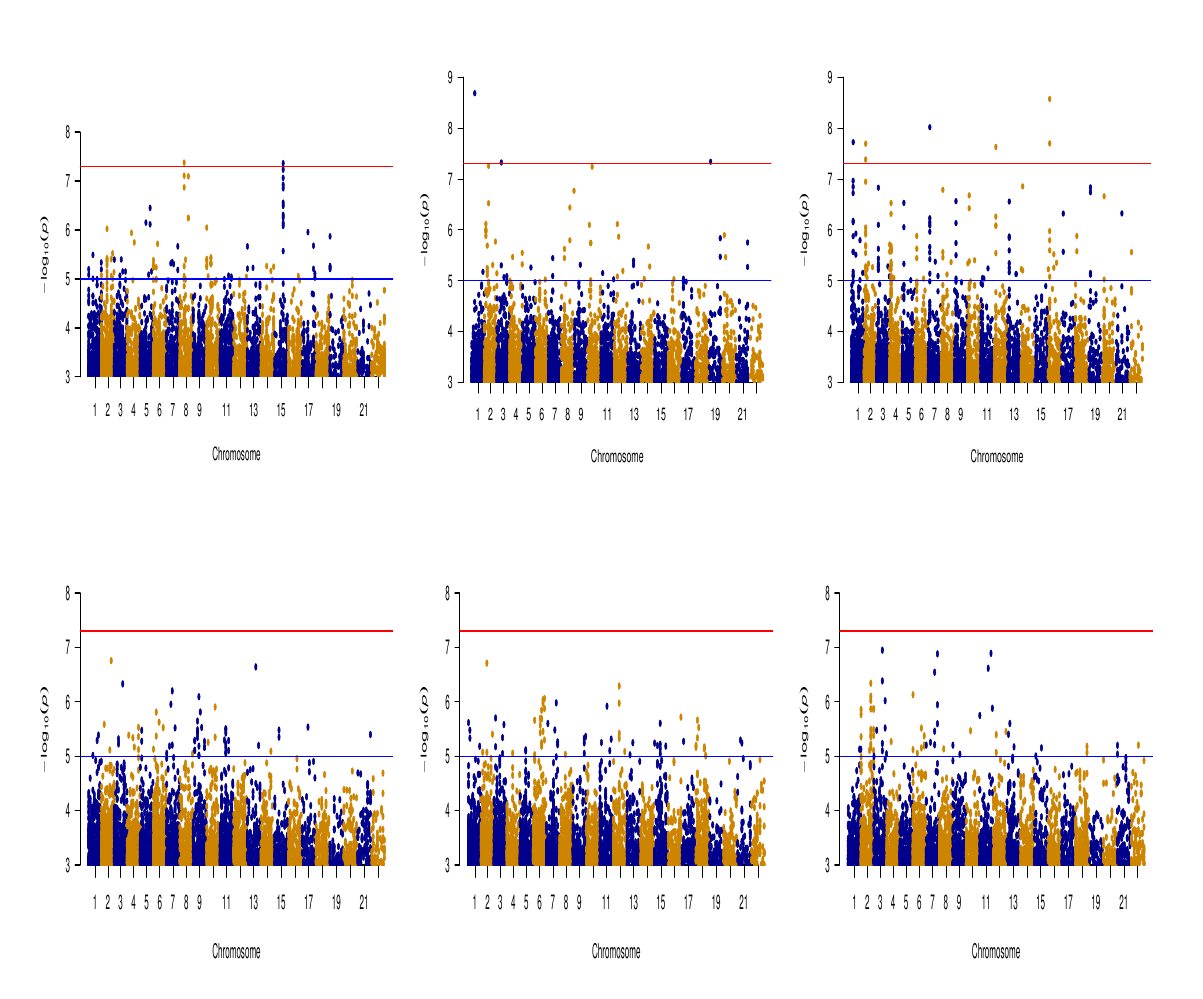
Figure 4. Manhattan plots. ( Top panels ) The left panel corresponds to binary classification of AD vs. CN; the panel in the middle is for whole-brain structure with augmentation; and the right panel is for the multi-branch model based on the whole-brain structure. ( Bottom panels ) The left panel is for the multi-branch model based on GM images; the middle panel is for the multi-branch model based on WM images; and the right panel is for the multi-branch model based on CSF